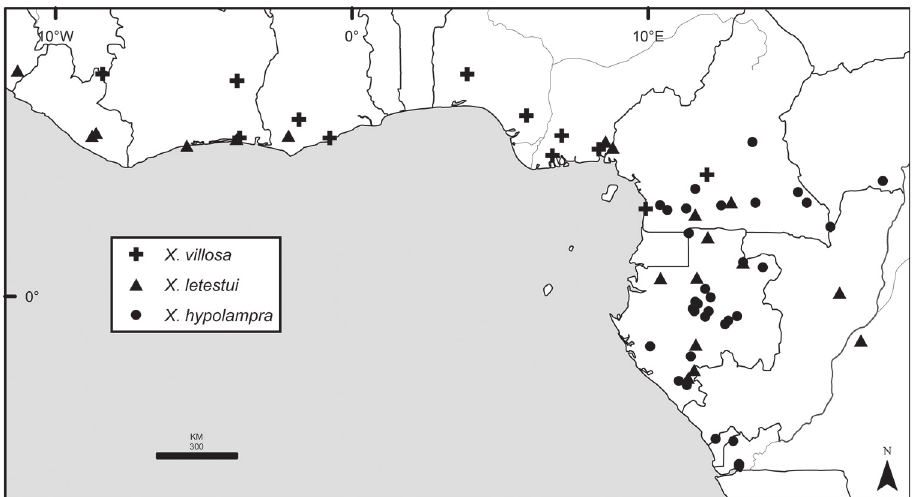
Figure 43. Distributions of Xylopia villosa , X. letestui , and X. hypolampra . Bolder lines represent country borders, fainter lines lakes and major